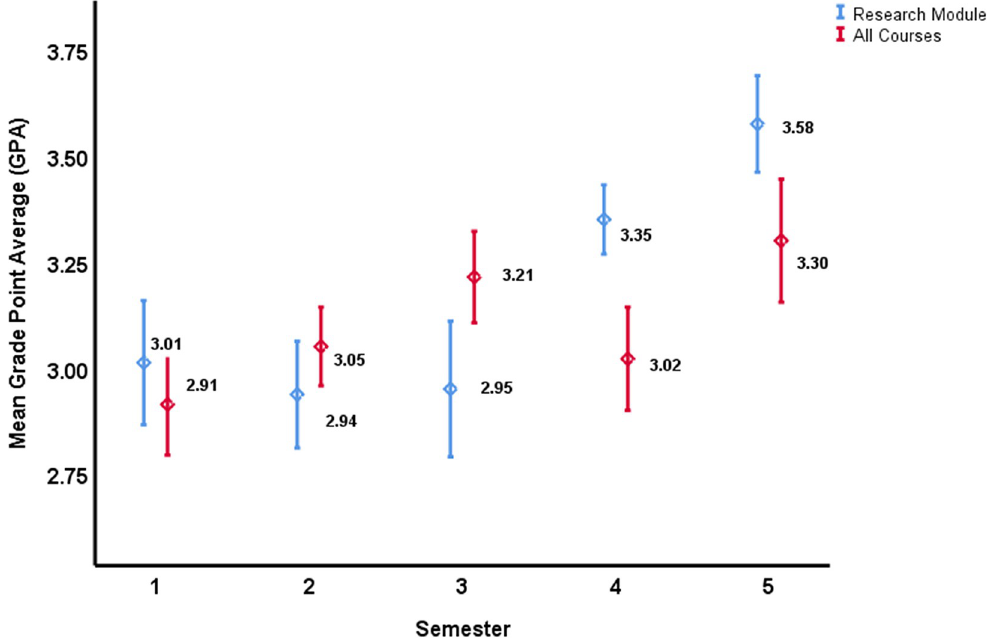
Fig 2. Mean Grade Point Average (GPA), with the corresponding 95% Confidence Interval (CI), for the research module courses (Blue), and all the MBBS program courses together (Red), offered in the respective semester . Blue lines- There are two distinct clusters of mean GPA values across the 5-integrated course modules: first cluster was for courses of semesters 1, 2, and 3, and the second cluster was for courses of semesters 4 and 5. The 95% CI for Semester 1, 2, and 3 overlap indicating no statistical difference between the three research courses given in the first 3 semesters. Similarly, the 95% CI for the research courses given in Semester 4 and 5 overlap indicating no statistical difference (p > 0.05). However, post-hoc ANOVA analysis revealed two distinct clusters of mean GPA, the first cluster (Semesters 1, 2, and 3) and the second cluster (Semesters 4 and 5) (p <